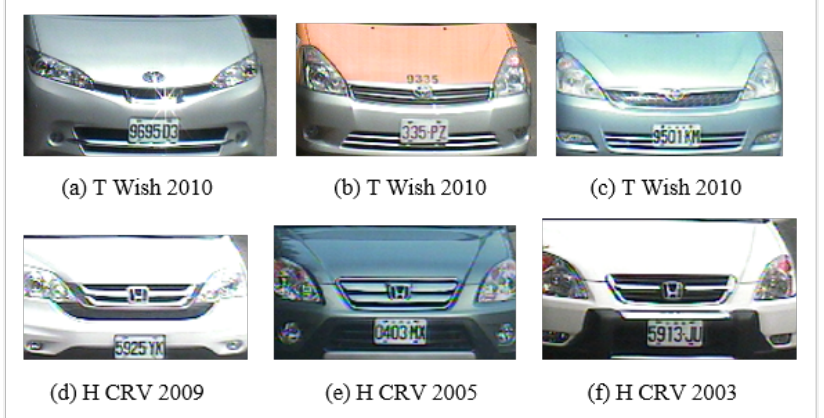
Figure 1. Multiplicity problems with ( a – c ) Toyota Wish (C4) and ( d – f ) Honda CRV (C11) in the NTOU-MMR dataset. The multiplicity problem means one VMM often displays different shapes due to different manufacturing